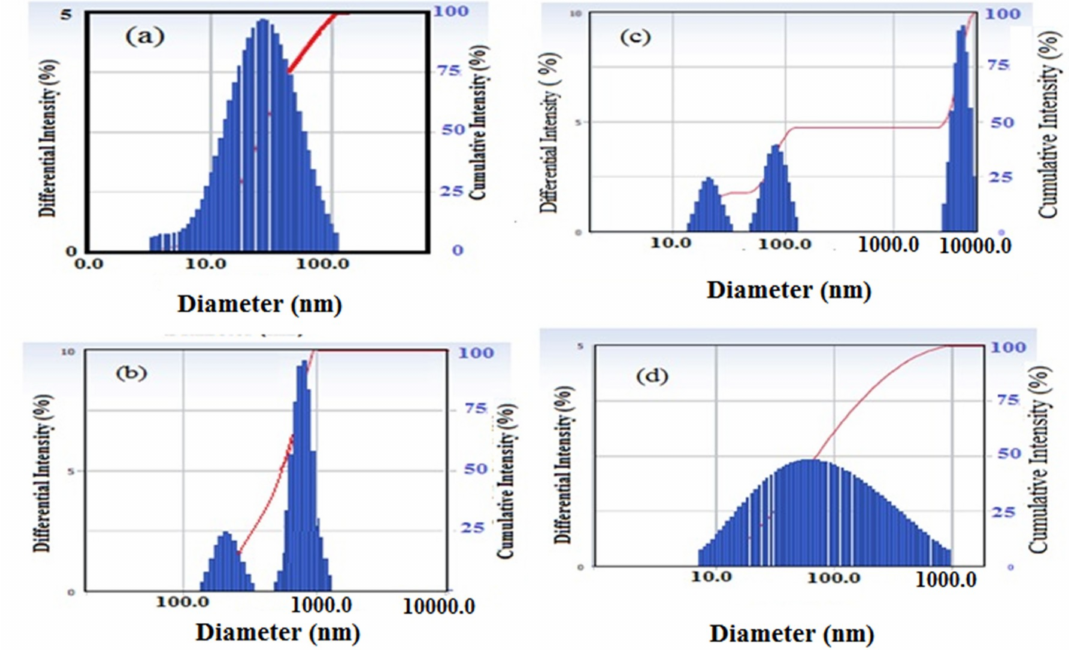
Figure 7. DLS data of ( a ) Fe 3 O 4 NPs; ( b ) QVP / AAm; ( c ) Fe 3 O 4 -QVP / AAm; ( d ) QVP / AAm-Fe 3 O 4 in dispersed in 0.001 M KCl water